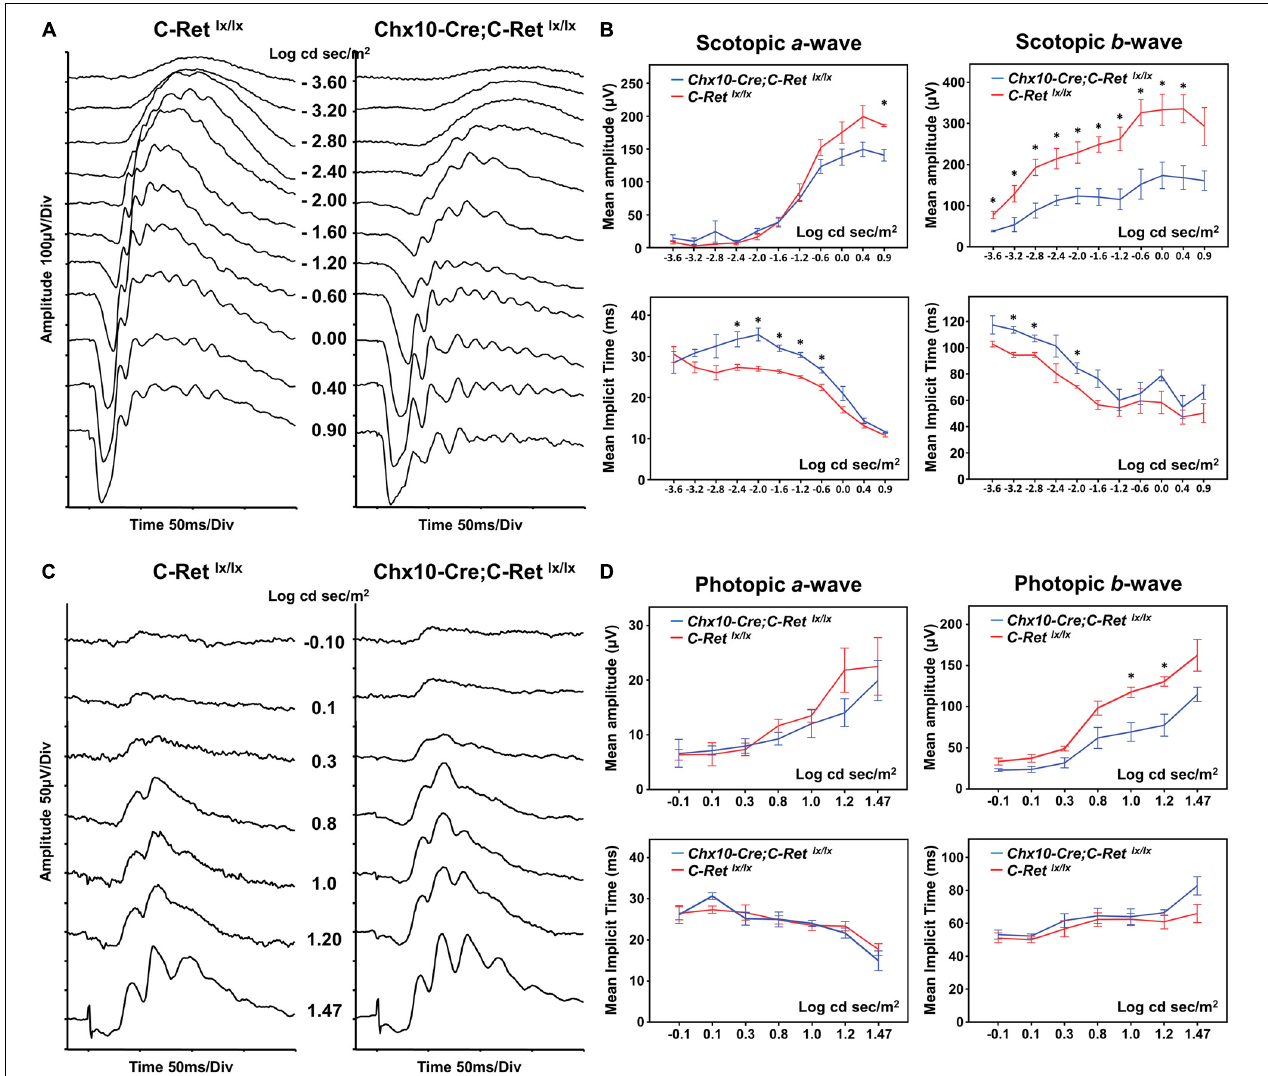
FIGURE 3 | Electroretinography (ERG) of C-Ret lx / lx and Chx10-CRE;C-Ret lx / lx mice. (A) Representative ERG waveforms were recorded from 12-month-old C-Ret lx / lx and Chx10-Cre;C-Ret lx / lx mice at increasing stimulus intensities in the scotopic phase. In Chx10-Cre;C-Ret lx / lx mice, a decrease in the b-wave and